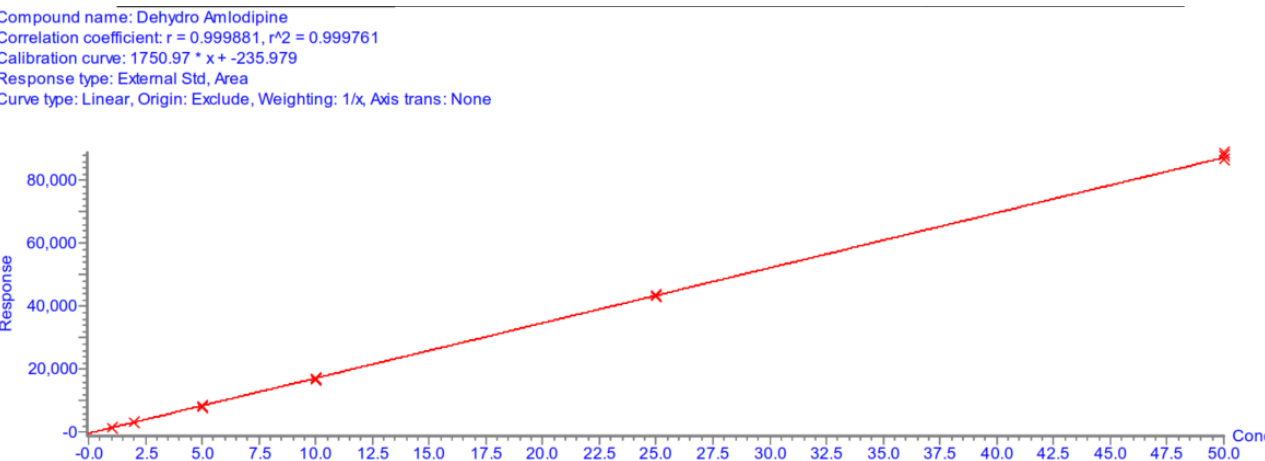
Figure A7. AML calibration curve in human plasma, concentration range 1 − 50 ng/mL, day 1.